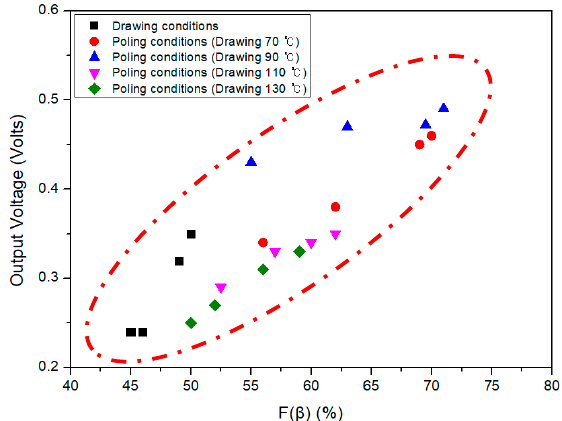
Figure 15. Correlation between F ( β ) and output voltage according to various drawing and poling treatments.